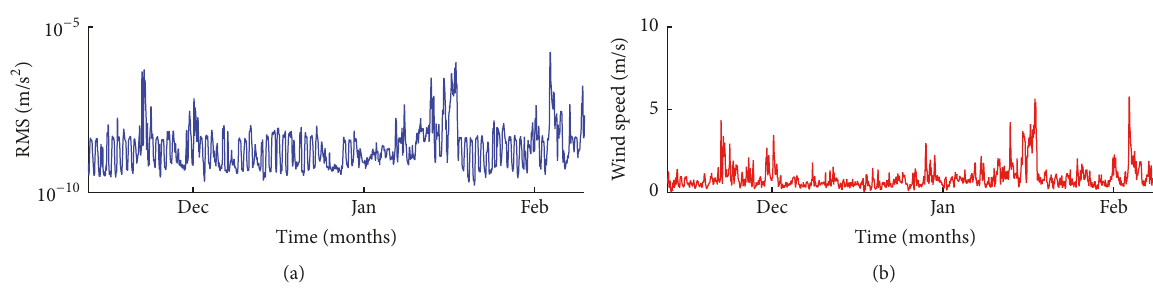
Figure 12: Trend of the vibration RMS (at floor 37 in 𝑥 direction, see Figure 1) (a) and the corresponding wind speed (b).